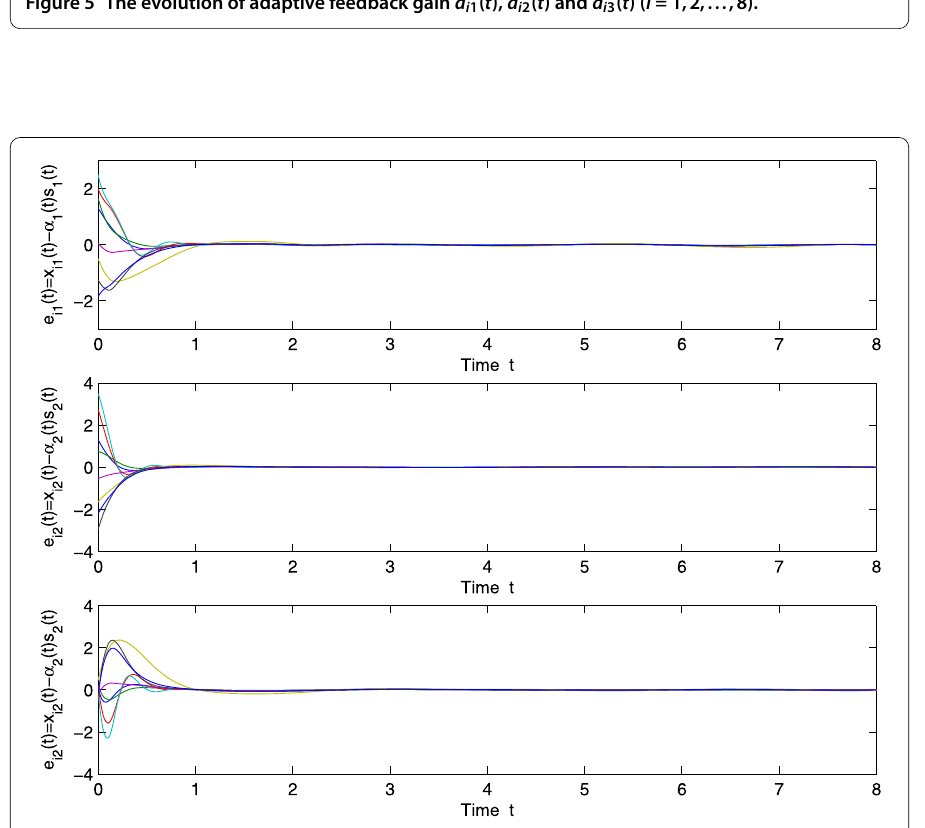
Figure 6 The modified function projective synchronization errors between the states of isolate node α ( t ) s ( t ) (38) and node x i ( t ) (39), i = 1,2,...,5, with hybrid adaptive pinning control